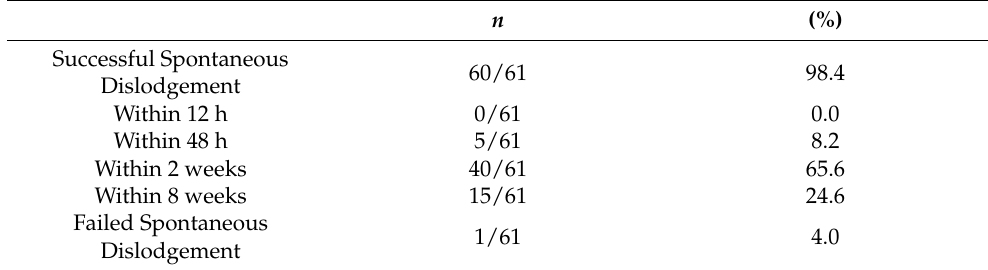
Table 4. The rate of spontaneous dislodgement of prophylactic pancreatic stents. n (%) Successful